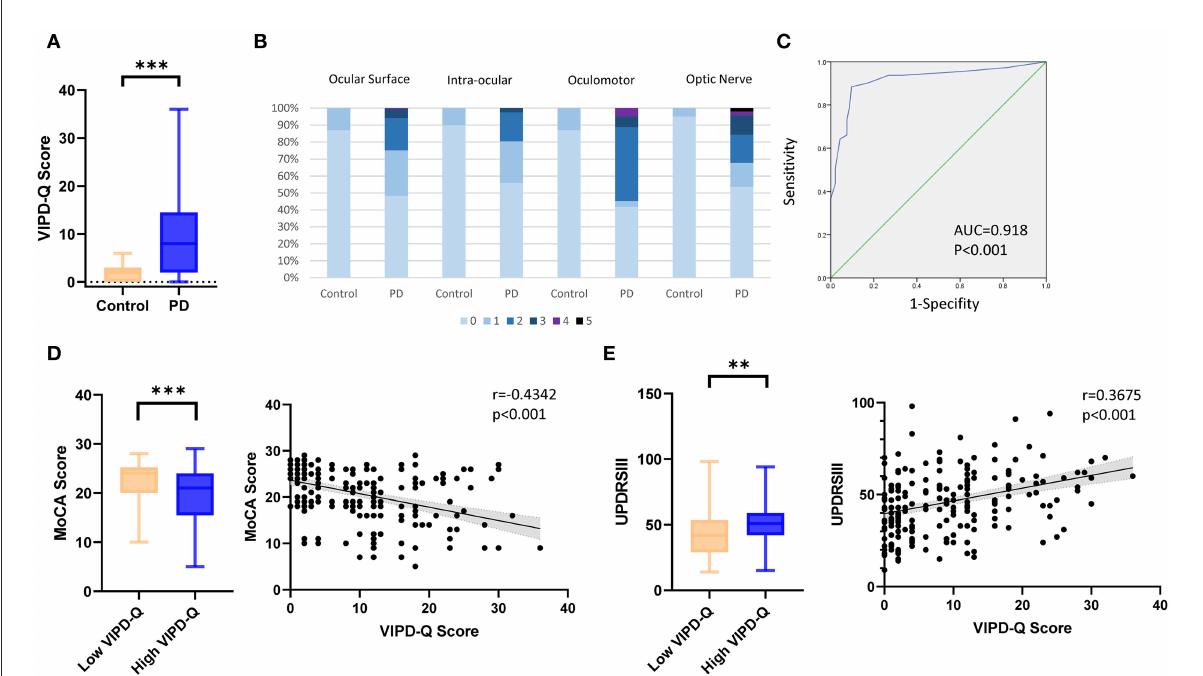
FIGURE1 VIPD-Q scores for patients with PD in relation to MoCA and UPDRSIII scores. (A) Boxplot of the median total VIPD-Q score in the PD and control groups. (B) Number of ophthalmologic symptoms reported per domain (compared between patients with PD and controls). (C) The validation